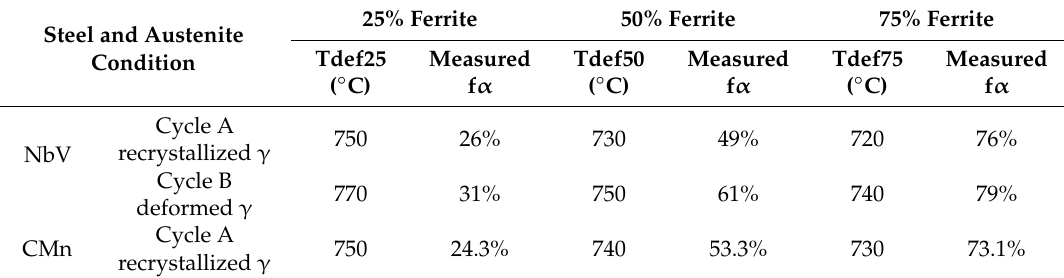
Table 2. Measured ferrite fraction in each deformation temperature, both chemical compositions, and austenite conditions after quenching.